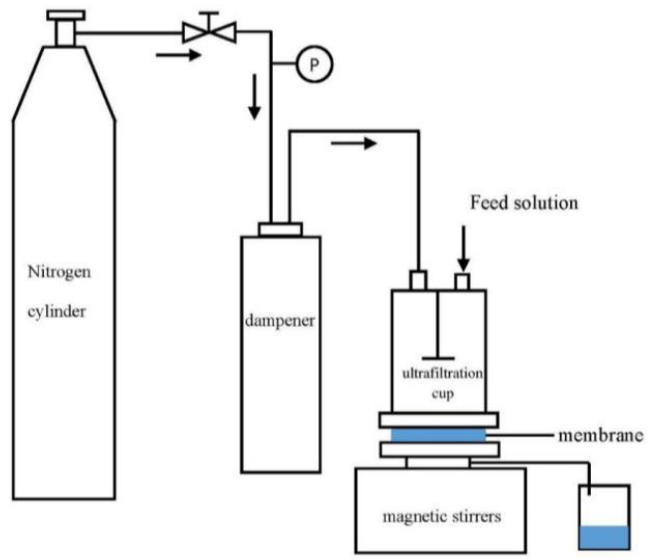
Figure 2. Schematic of dead-end stirred ultrafiltration cup setup. The pore size and porosity of the membrane were measured by a weighing method.